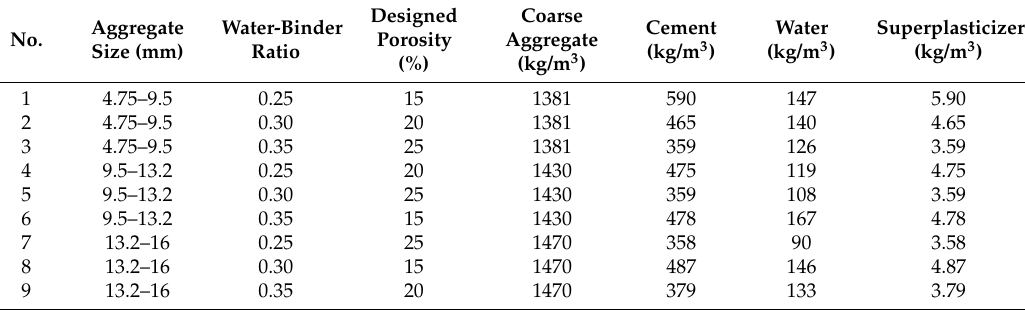
Table 3. Mix ratio of pervious concrete